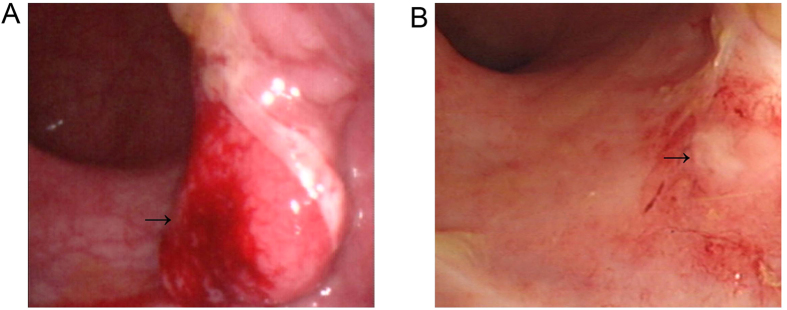
Colonoscopy images.(A) Pre-treatment. (B) Six months after the combined treatment. There was no residual tumor after treatment.